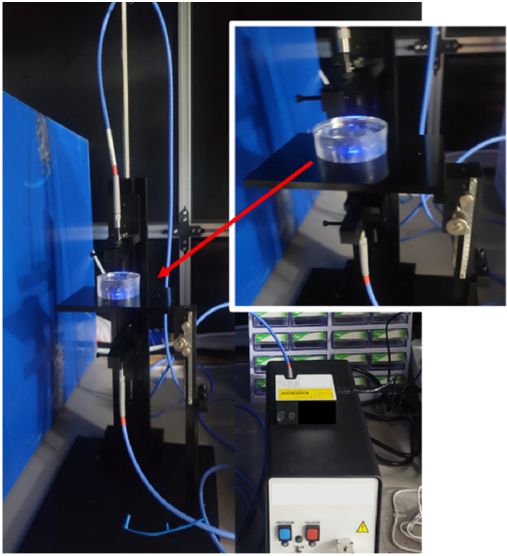
Figure 2. Apparatus setup for measurements of absorption and transmission based on fabricated plastic scintillator.